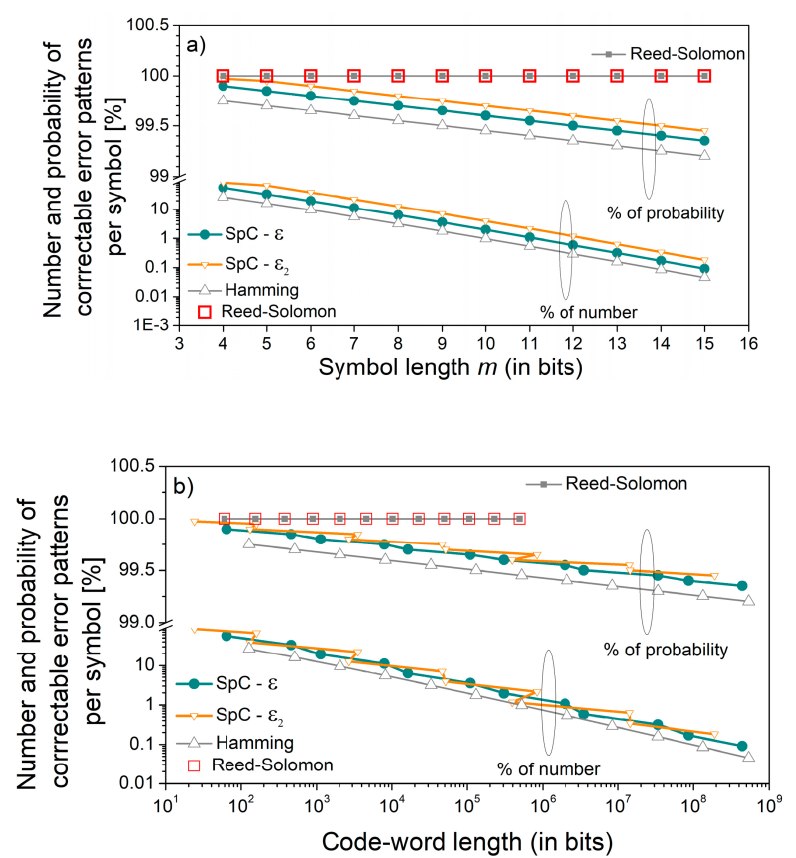
Figure 5. The number and probability of correctable error patterns per symbol with respect to total number of error patterns, and probability of all error patterns, expressed in %; ( a ) symbol length m as a parameter; ( b ) maximal code-word length as a parameter. The percentage of correctable patterns is low, but these are the most probable patterns in the case of isolated and statistically independent errors. The increase in code-word length for splitting code with ℰ 2 is not monotonous, as can also be seen in Figure 4.